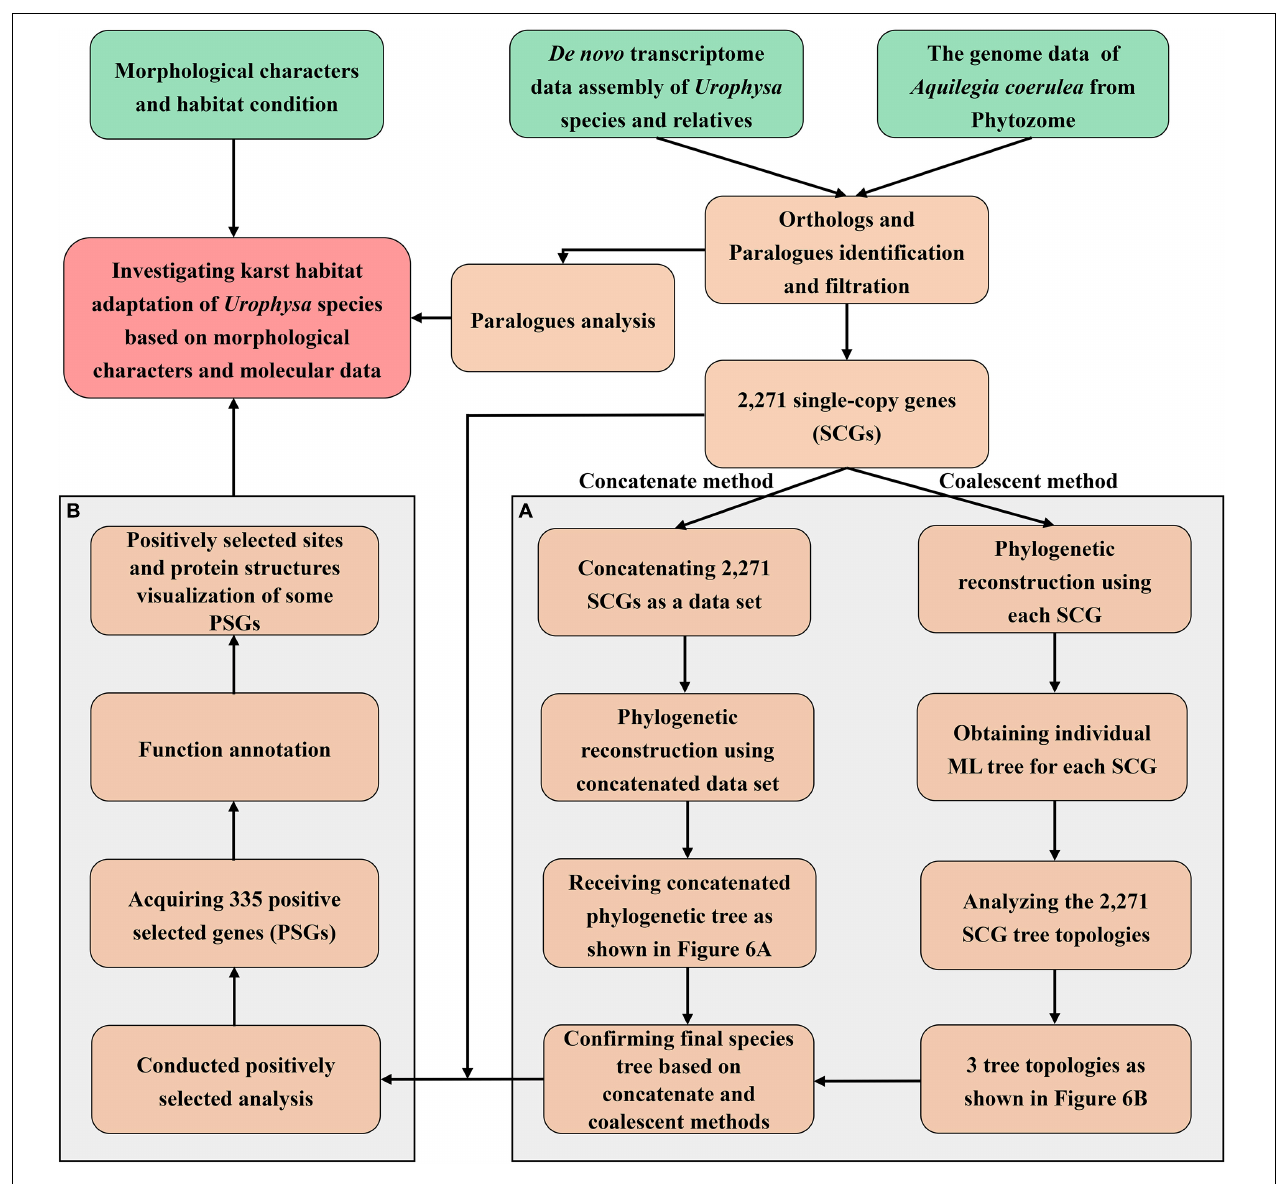
FIGURE 2 | The detailed analysis procedures performed in this study. (A) The phylogenetic analysis workflow including concatenate and coalescent methods; (B) procedures of positive selection